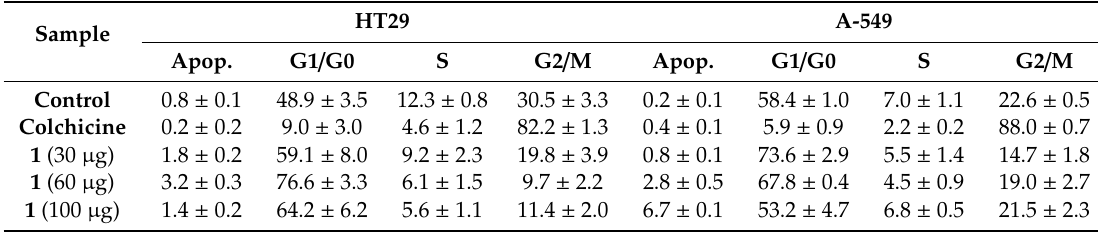
Table 3. Flow cytometry of phyllocladan-16 α , 19-diol ( 1 ) against colon and lung cancer cells.